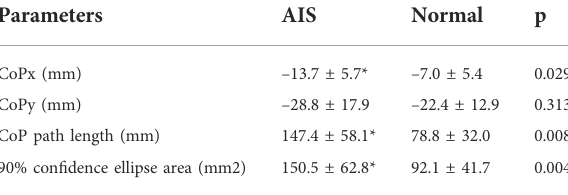
TABLE 2 Static balance parameters in adolescent idiopathic scoliosis (AIS) and normal subjects ( n =